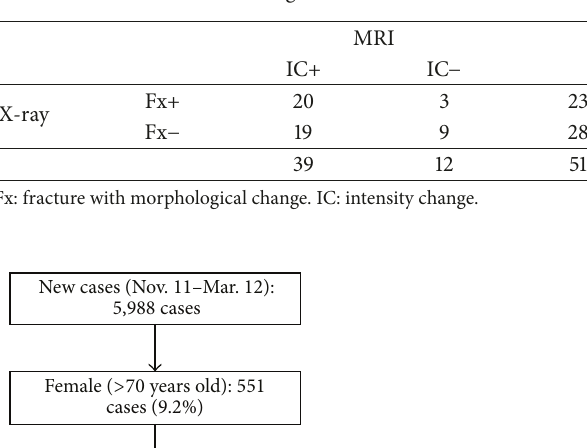
Table 1: Radiological distributions.